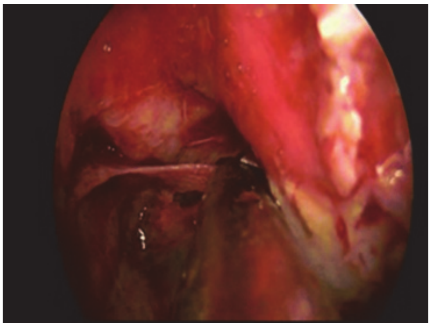
Figure 5: Endoscopic image: posterior ethmoidal artery in its bony shell.